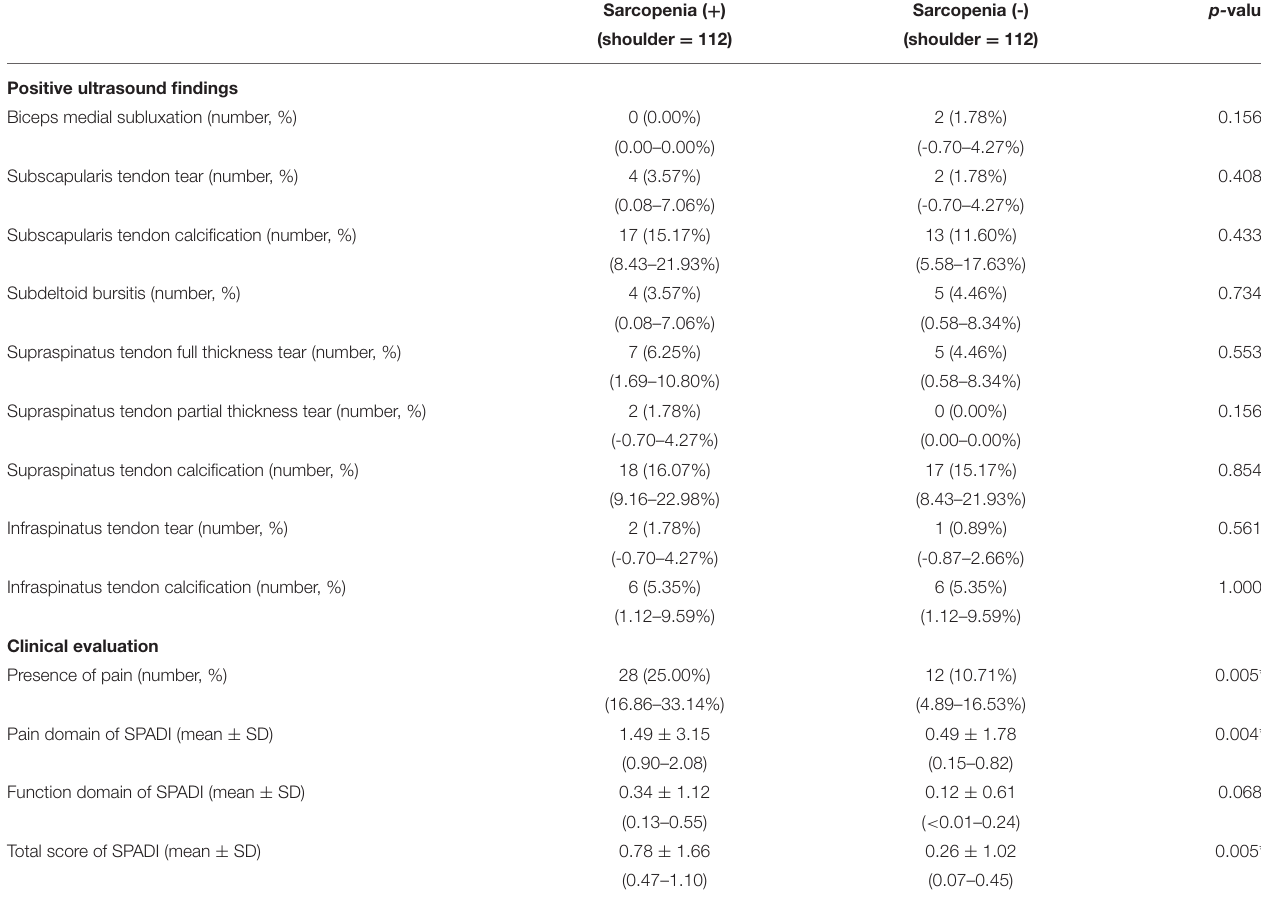
TABLE 1 | Descriptive ultrasound findings and clinical evaluation of the study participants. Sarcopenia ( + ) Sarcopenia (-) p-